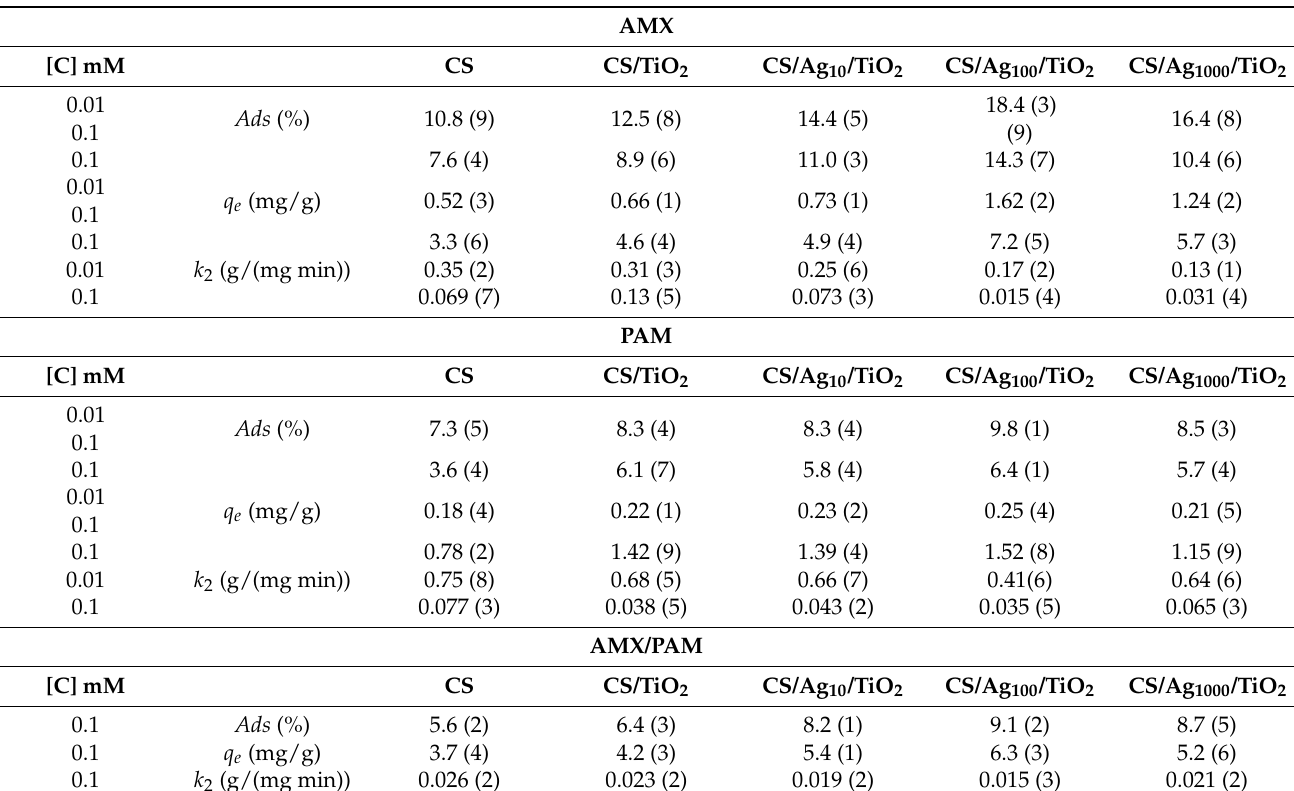
Table 1. Adsorption percentage Ads %, adsorption capacity q e and PSO ads kinetic constant k 2 of AMX, PAM and AMX/PAM for the different scaffolds and for two different PhCs concentrations [C]. k 2 was obtained by fitting the experimental curves through Equation (6). Standard deviation in